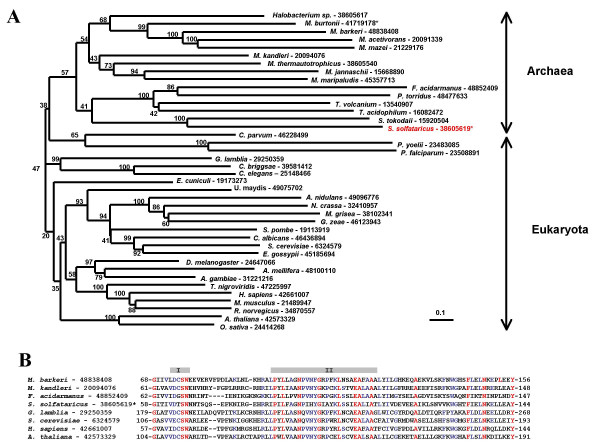
COG2042 sequences comparison. A – Phylogenetic analysis of archaeal and eukaryal COG2042 sequences. Archaeal and eukaryal homologs were obtained from public databases [54] by PSI-BLAST searches. To get the most conserved alignment between COG2042 polypeptide sequences, most probable start codons should be considered as atg at nucleotide 500978 on Crick strand for MTH554 from Methanothermobacter thermoautotrophicus str. DeltaH (NC_000916), gtg at nucleotide 1526308 on Watson strand for Vng2075c from Halobacterium sp. NRC-1 (NC_002607), atg at nucleotide 8398 on Watson strand for Mbur141901 from Methanococcoides burtonii DSM6242 (NZ_AADH01000008) and atg at nucleotide 484790 on Crick strand for SSO0551 from S. solfataricus (NC_002754). Asterisks indicate modified protein sequences according to this new proposed annotation. Multiple alignments were performed by ClustalW. Following removal of a few ambiguously aligned regions, a data set was assembled comprising 40 sequences over 162 amino acid positions. An unrooted evolutionary distance tree was constructed based on Kimura distances and neighbor joining tree reconstruction algorithm. Bootstrap confidence levels at nodes were computed by the Phylips package with 400 replicates. Scale bar represents unit of amino acid substitutions per position. Accession numbers (gi) are indicated beside the organism. B – Conserved sequence blocks in the alignment of COG2042 members. Based on the phylogenetic analysis (Panel A), eight representative sequences were selected out of 40 COG2042 sequences. Four first sequences are from Archaea while last four sequences are from Eukaryota. SSO0551 sequence (gi38605619) from S. solfataricus, labeled with an asterisk, has been numbered according to the new annotation proposed in RESULTS section. Invariant residues in the eight sequences are shown in red and conserved residues in blue. Two conserved motifs commented in the results section are indicated with grey boxes.